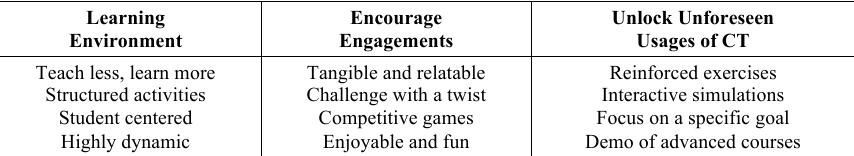
Table 1. Keys to facilitate collaborative computational thinking in active learning